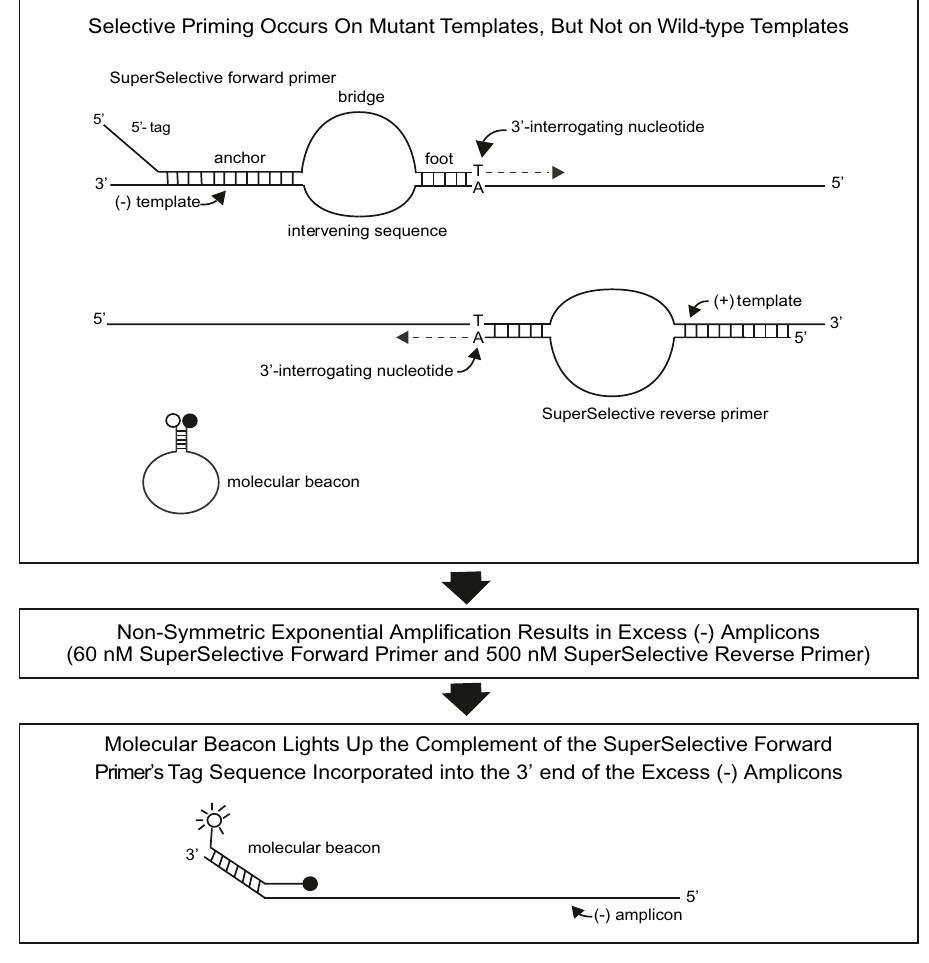
Figure 1. Design of PCR assays that utilize SuperSelective primer pairs for the selective amplification of rare mutant DNA target fragments in the presence of abundant DNA fragments from the entire human genome. After the SuperSelective primer pair initiates synthesis of amplicons on mutant target fragments (but does not initiate amplification on closely related wild-type DNA fragments), the resulting amplicons contain each primer’s bridge sequence in place of their target’s intervening sequence complement. Consequently, subsequent exponential amplification is highly efficient, since the entire sequence of each SuperSelective primer is complementary to the amplicons. Since the concentration of the forward primer is limited, and is eventually used up, the excess reverse primer continues linear amplification, creating readily available targets for molecular beacon probes, whose fluorescent color identifies their target